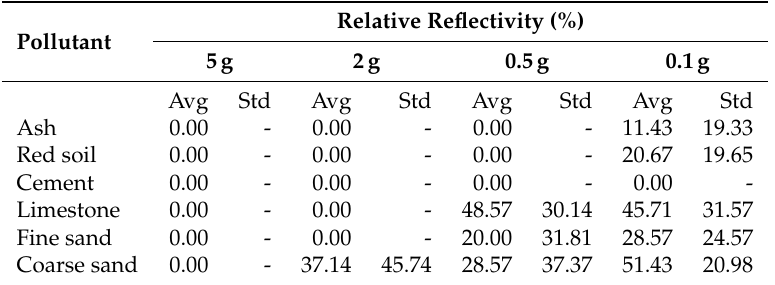
Table 6. Relative reflectivity of the pollutants in the visible